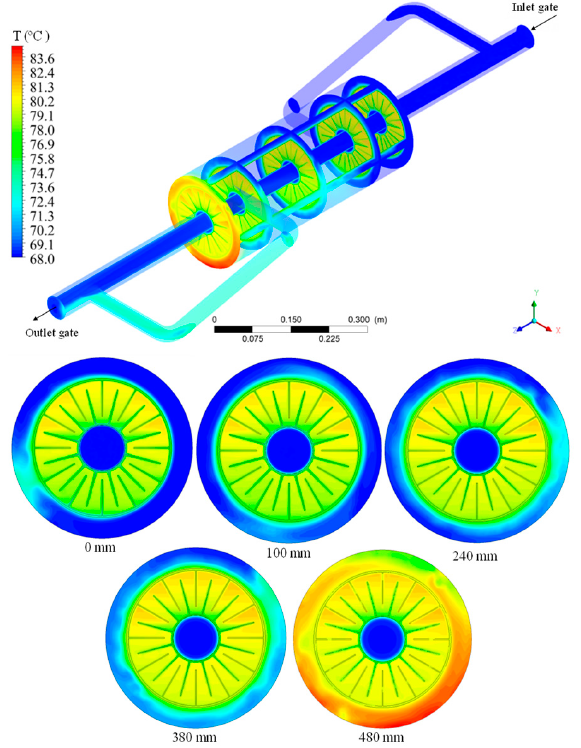
Figure 10. Temperature distribution in TTHX domains for 80% of the PCM in a liquid state (t = 4942 s).